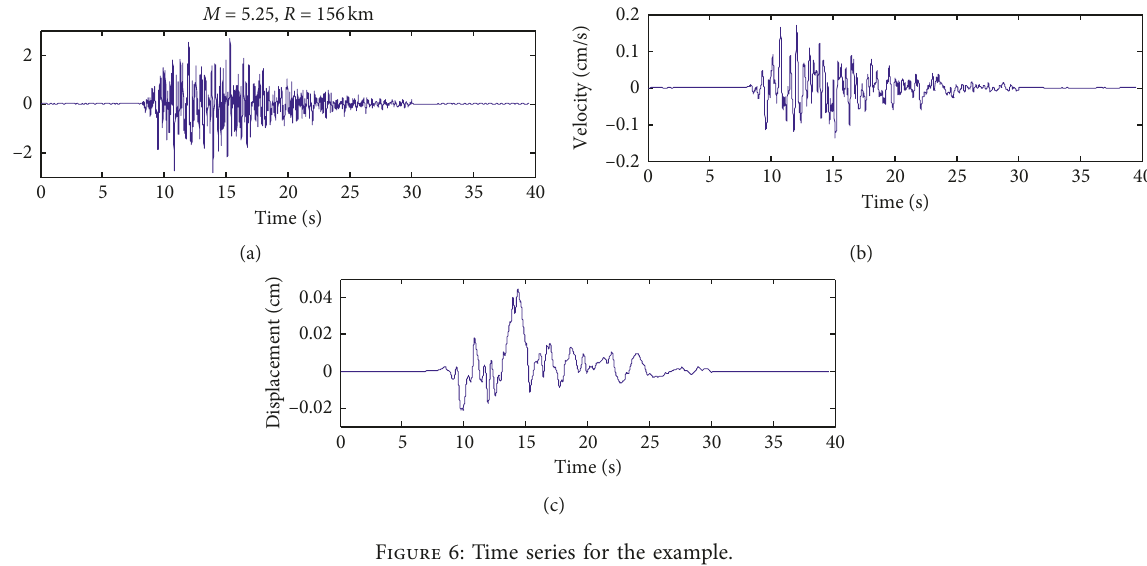
Figure 6: Time series for the